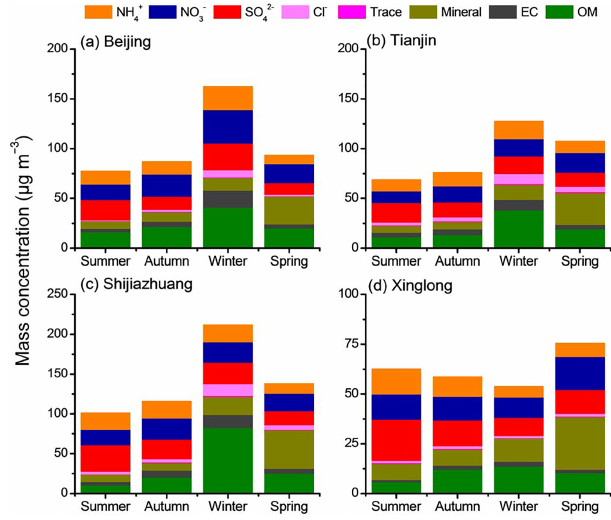
Figure 4. Seasonal variations in the major chemical components of PM 2 . 5 at the four